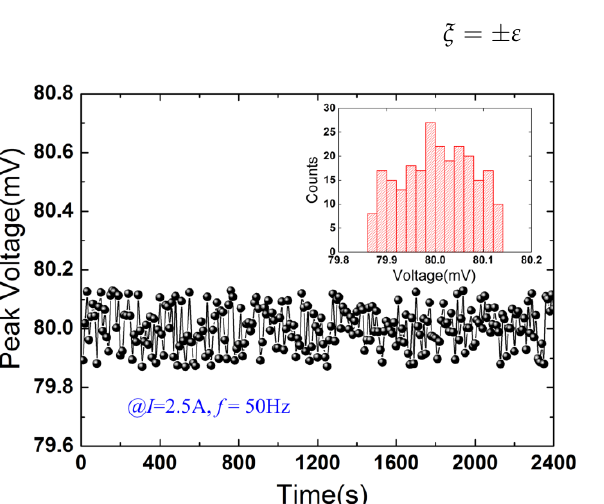
Figure 6. Induced voltage as a function of time at 2.5 A. The inset plots the histogram of the voltages.